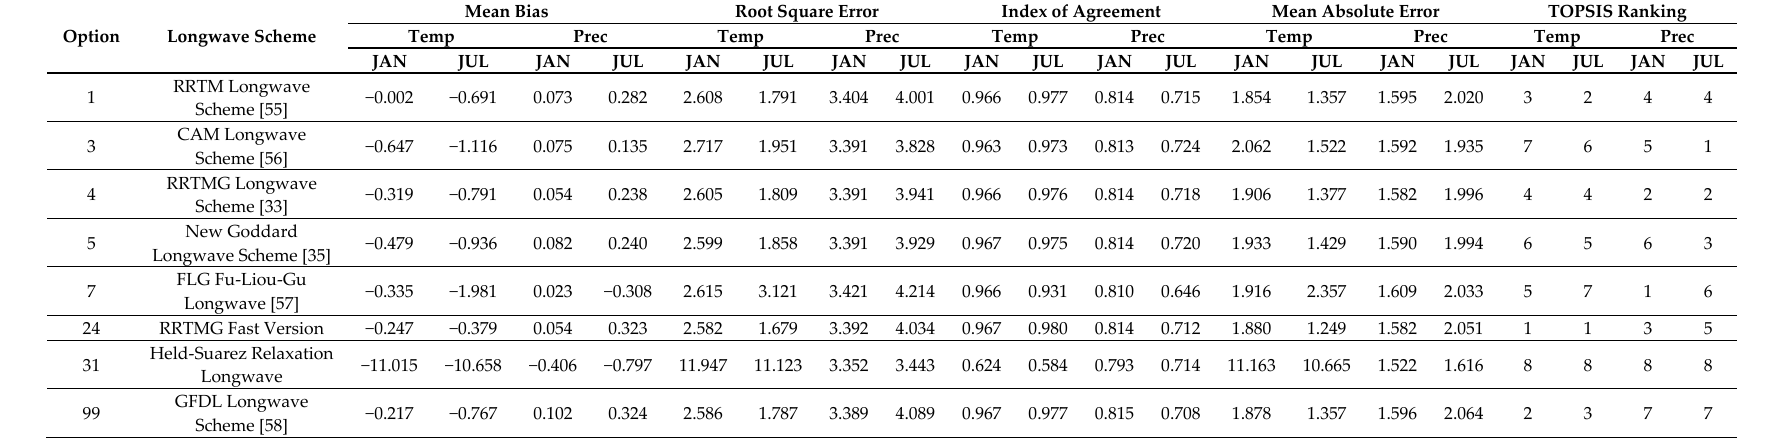
Table 5. Statistical measures and TOPSIS ranking for the Longwave Radiation simulation